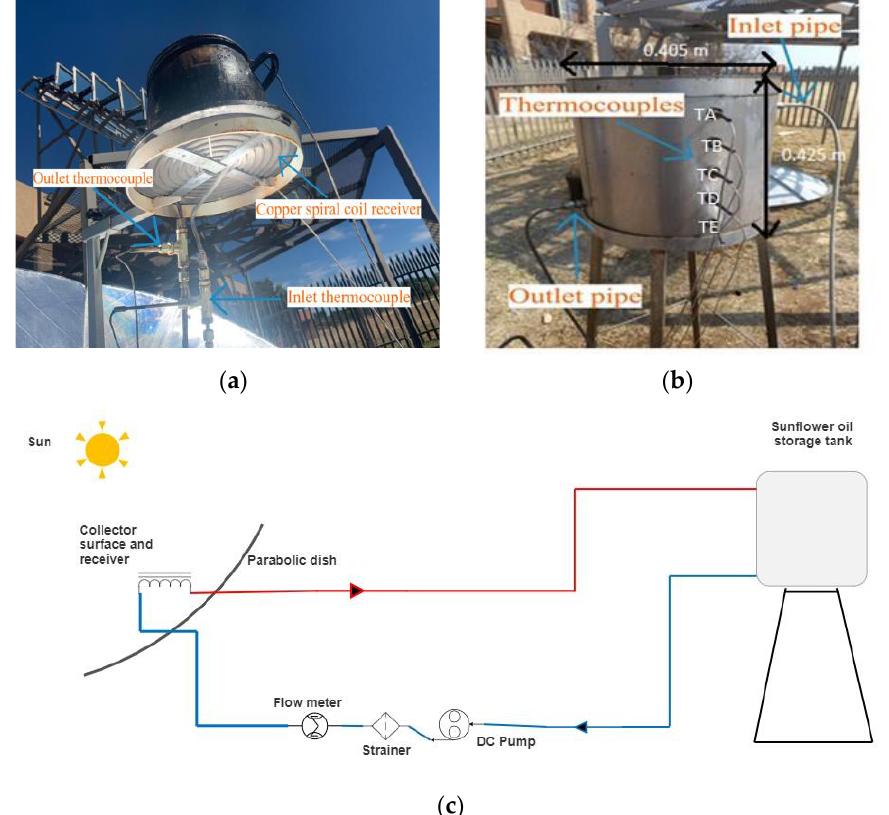
Figure 2. Photographs of the ( a ) receiver, ( b ) storage tank, and ( c ) a schematic flow diagram of the experimental setup.